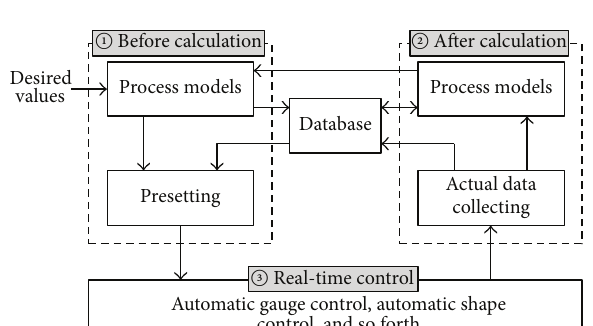
Figure 2: Process control system of a plate